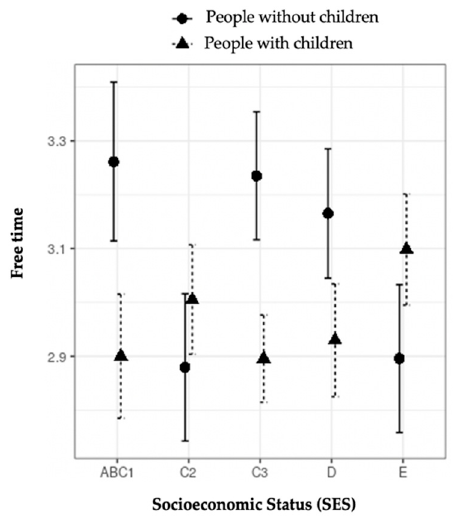
Figure 3. Moderation effect of age on free time in people with and without children.